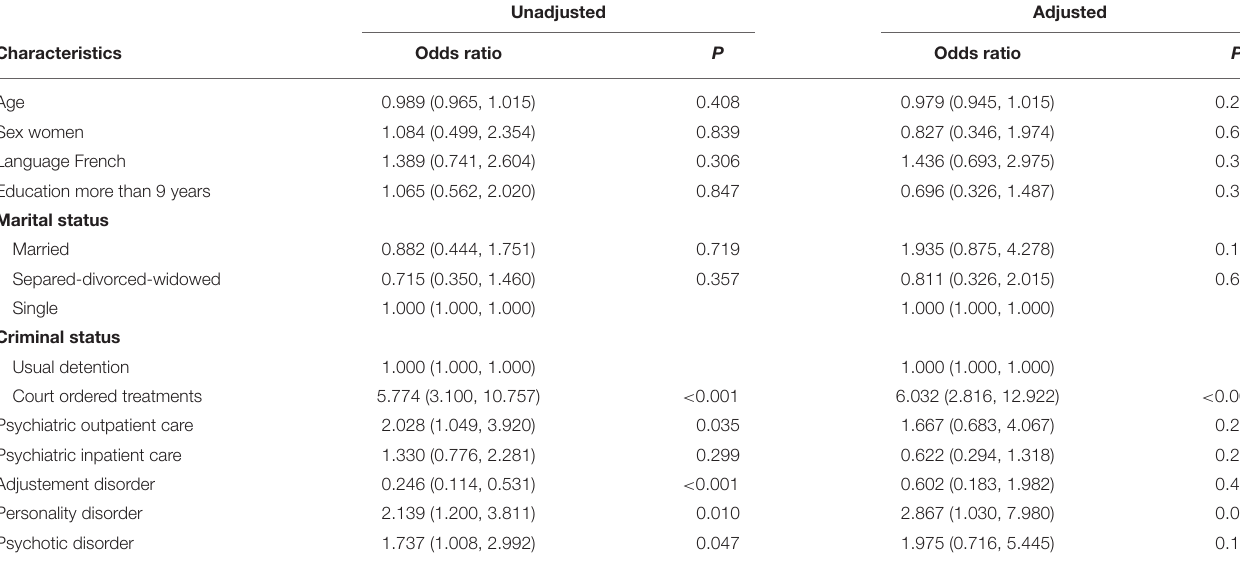
TABLE 2 | Results of univariate (unadjusted OR) and multiple (adjusted OR) ordered logistic regression associated with more frequent admissions (3